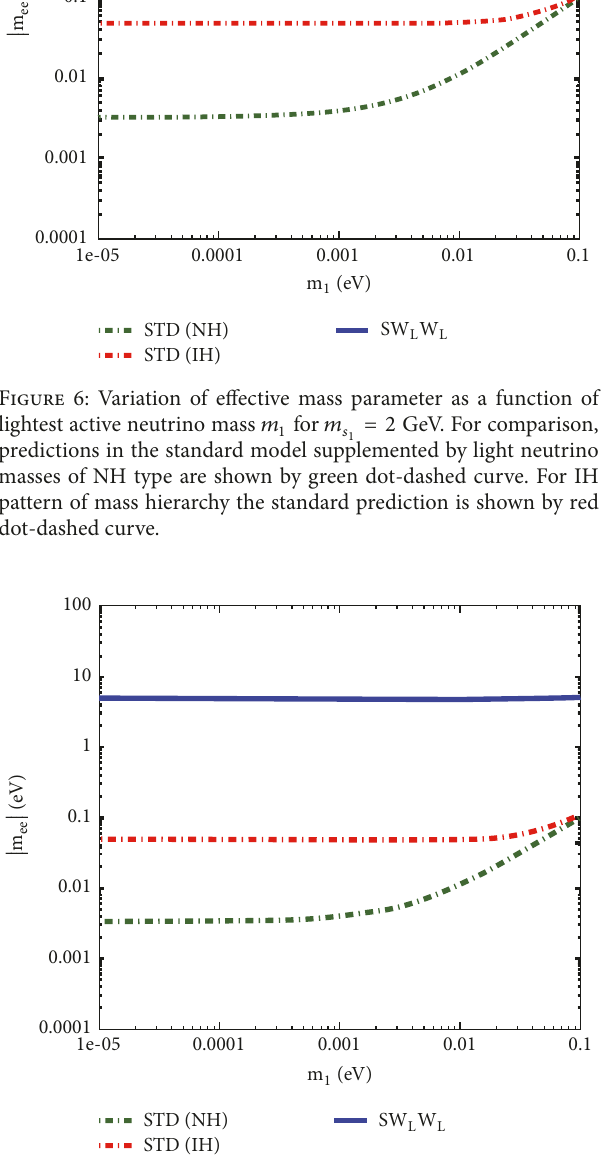
Figure 7: Same as Figure 6 but for 𝑚 푠